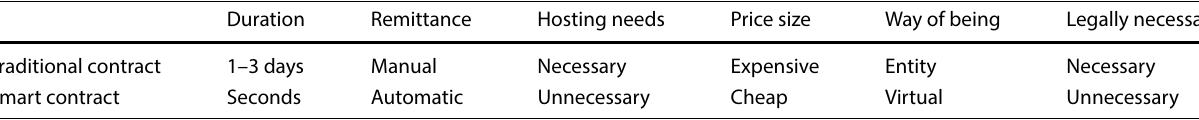
Table 1 Comparison of smart contracts and traditional contracts